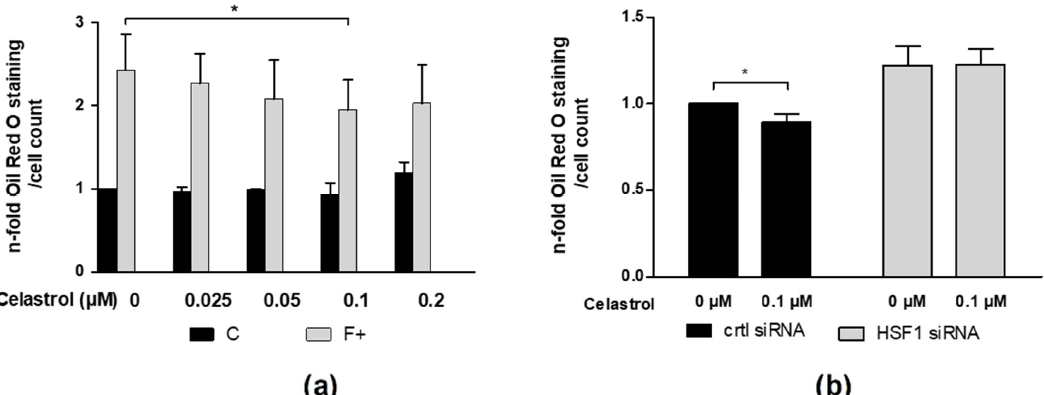
Figure 7. Activation of HSF1 by celastrol diminishes fat accumulation in HepG2 cells. HepG2 cells were stimulated with indicated concentrations of celastrol and cultured in control or PA/OA medium for 96 h. Intracellular fat accumulation was measured by Oil-Red-O staining ( a ). HepG2 cells were transfected with HSF1 or control siRNA. After 24 h, cells were treated with 0.1 µ M celastrol and cultured in control or PA/OA medium for 96 h. Fat accumulation was measured by Oil-Red-O staining ( b ). The figures depicts the mean values of three independent experiments performed in duplicates ± S.D. * p -values <